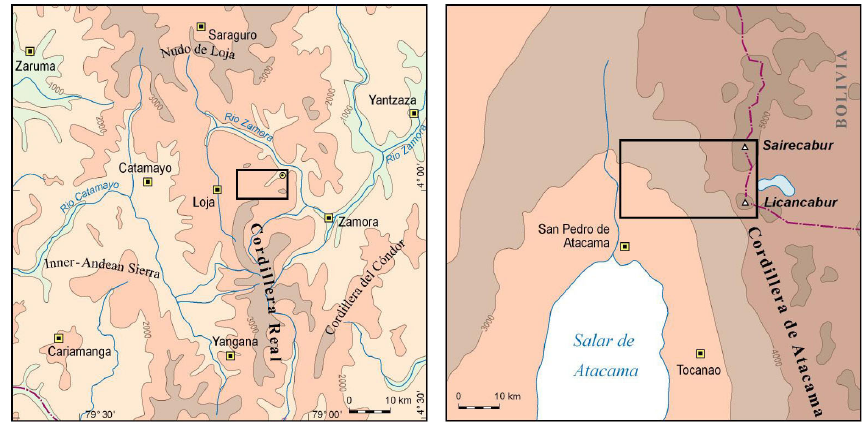
Fig. 1. Location of the study areas in southern Ecuador (left) and in northern Chile (right). Note the different extension of 250km 2 in the first and 725km 2 in the second case. While the smaller area of the Rio San Francisco Valley contains ca. 2000 native vascular plant species the more extended one west of the volcanoes Sairecabur and Licancabur hosts only ca.